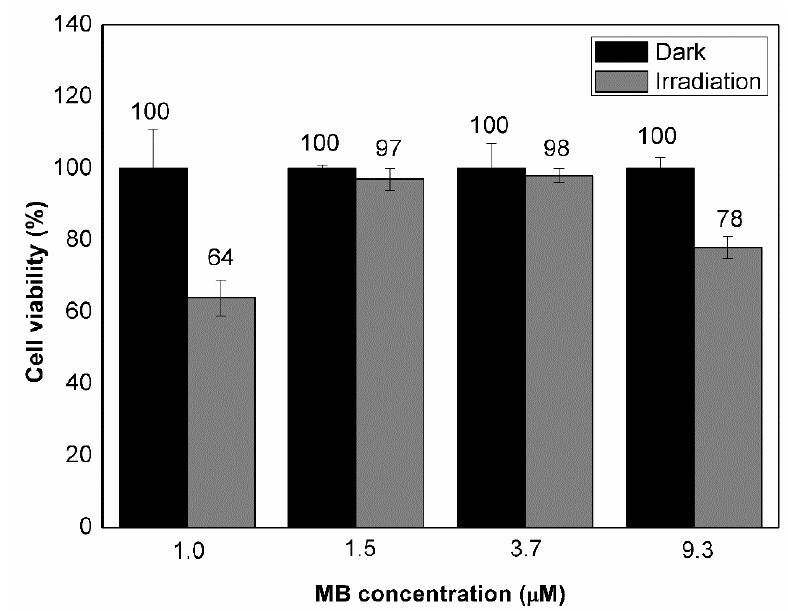
Figure 7. Viability of B16F10-Nex2 cells incubated with VMB-NPs containing encapsulated veliparib (8.3, 11.0, 28.0 and 69.0 µ M) and MB (1.0, 1.5, 3.7 and 9.3 µ M) at different concentrations in the dark and under laser irradiation (102 J/cm 2 , 660 nm). Values are depicted as mean values and standard deviation ( n = 3).